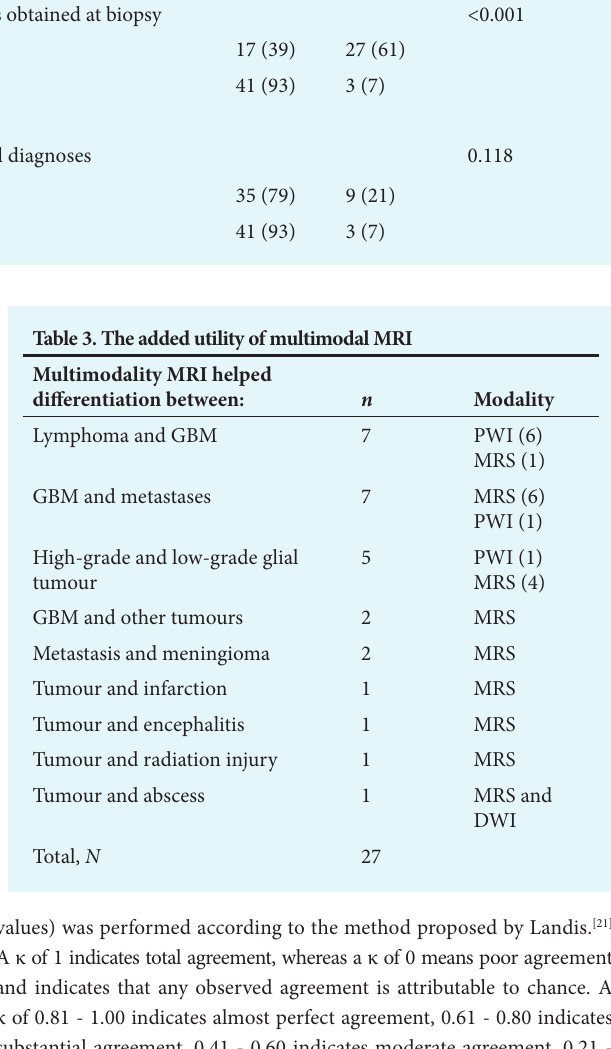
Single given diagnosis was the same as the final histopathological diagnosis obtained at biopsy <0.001